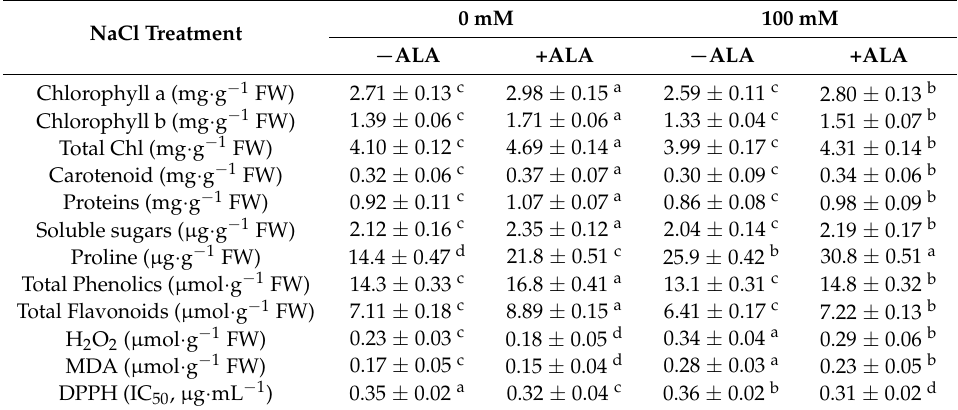
Table 4. Contents of chlorophyll, carotenoids, proteins, sugars, proline, phenolics, flavonoids, H 2 O 2 , malondialdehyde (MDA) and antioxidant activity (DPPH) in leaves of Slaski 2 cultivar under salt and/or ALA (7 ppm) treatments.